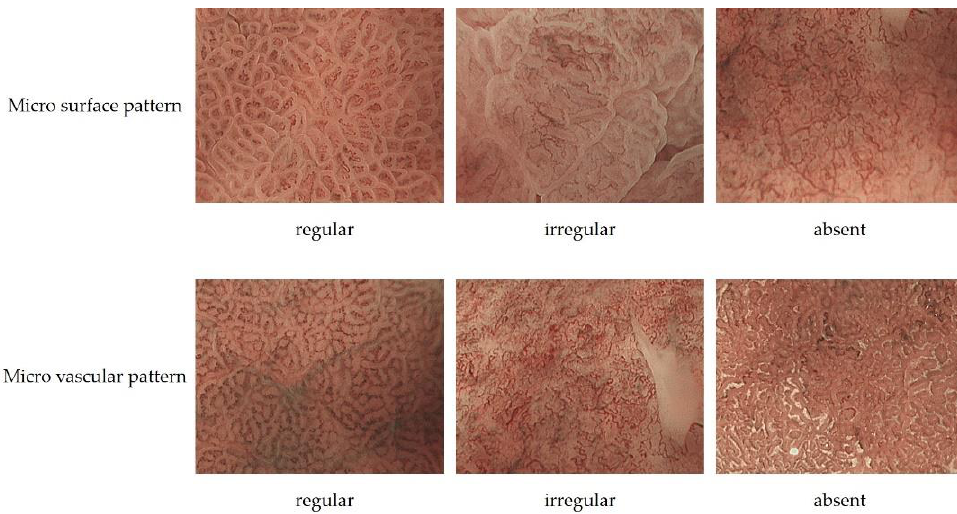
Figure 5. The upper row is an example of regular MSP, irregular MSP, and absent MSP. The bottom row is an example of regular MVP, irregular MVP, and absent MVP. Table 1. Differences in MSP and MVP between cancer and non-cancer.